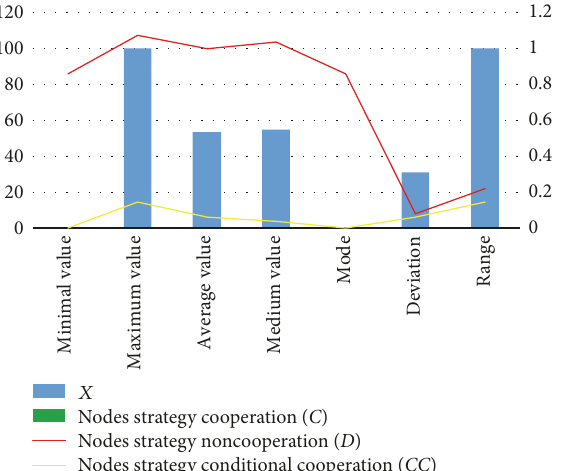
Figure 21: The state of population when 𝐶 𝐶 = 0.01 and 𝑥 = (0.33, 0.33, 0.33).